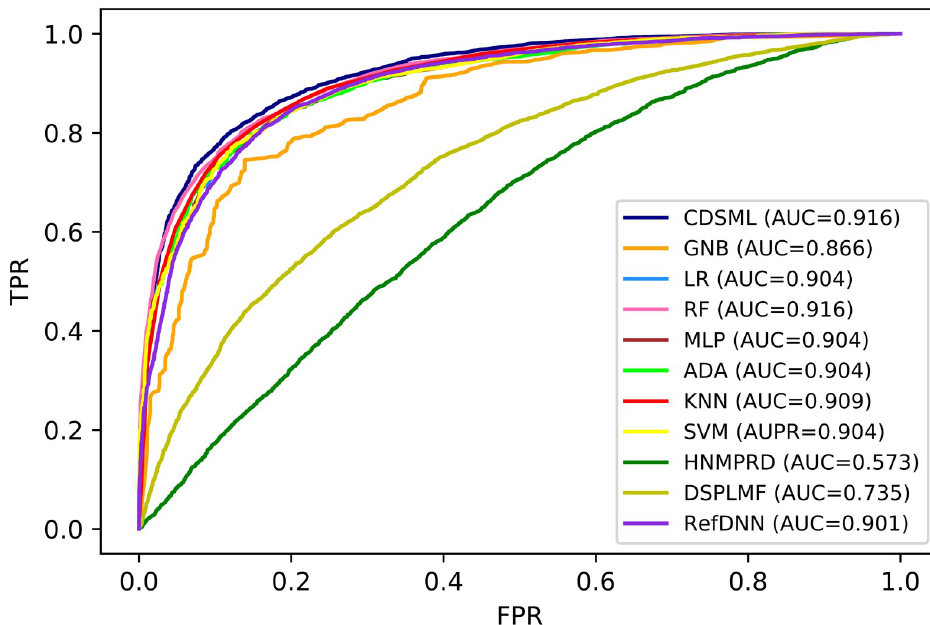
Fig 5. The ROC curve of all classification methods on GDSC